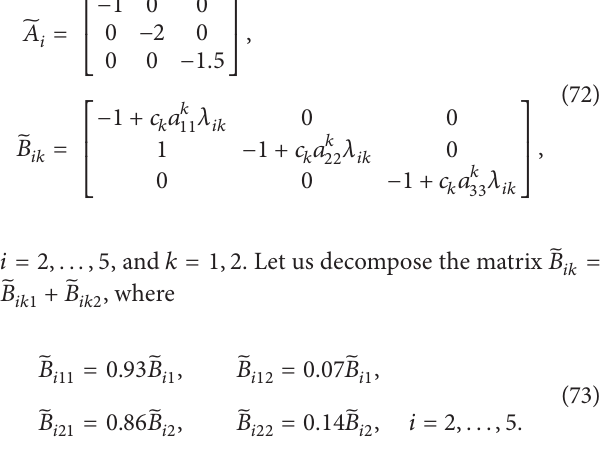
= 0.5 , ℎ(𝑡) = 0.5 + 0.715| cos 𝑡| and 1